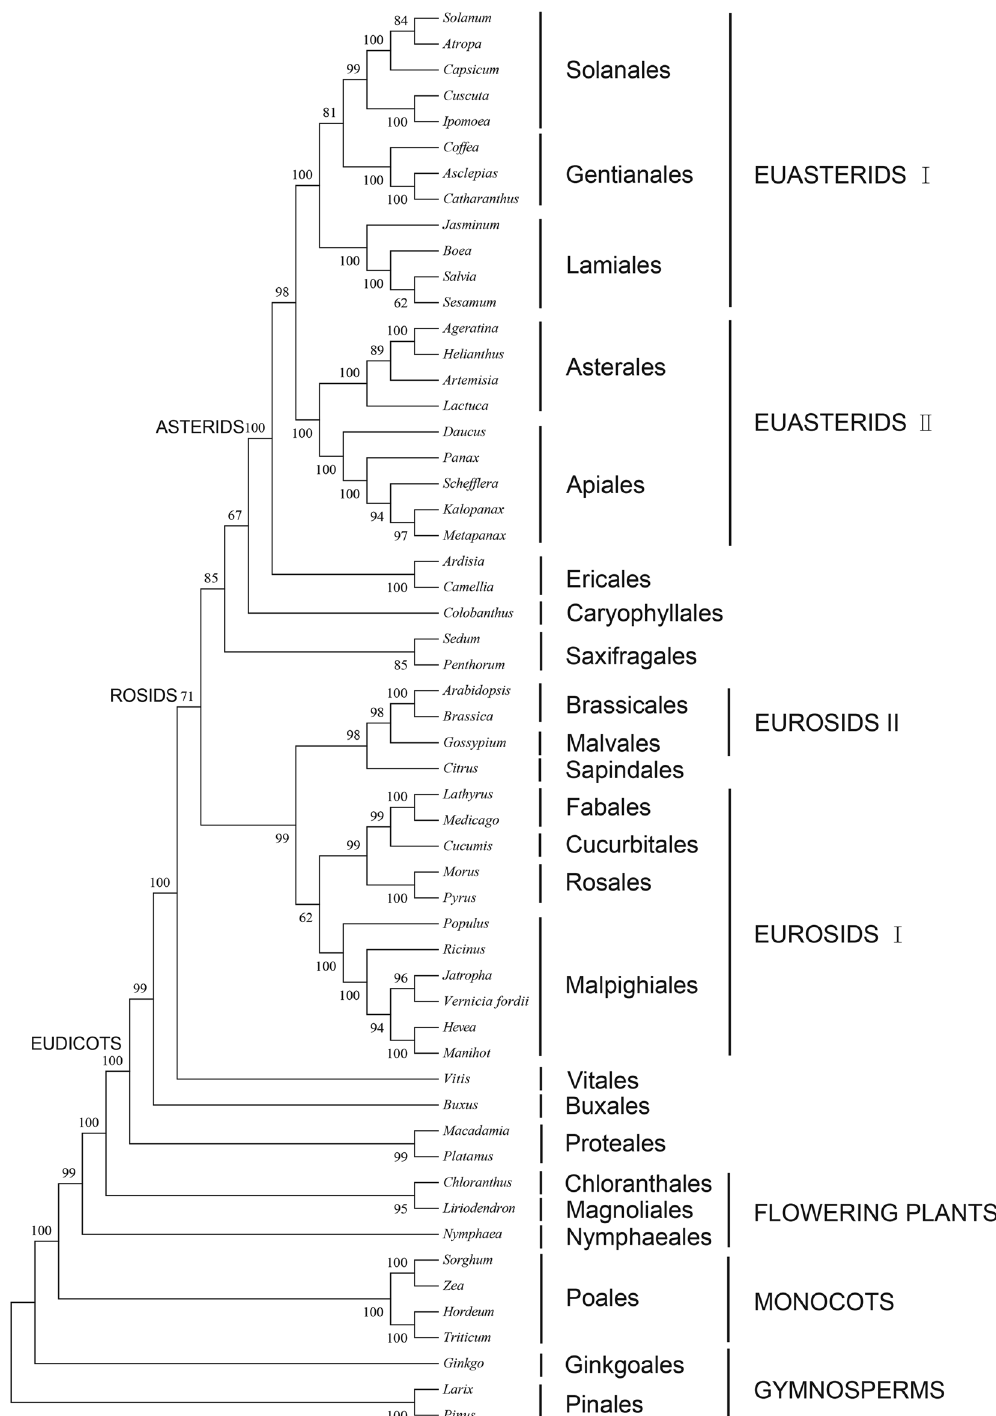
Figure 4. The maximum parsimony (MP) phylogenetic tree based on 36 protein-coding genes in the chloroplast genome. The numbers in each node was tested by bootstrap analysis with 1000